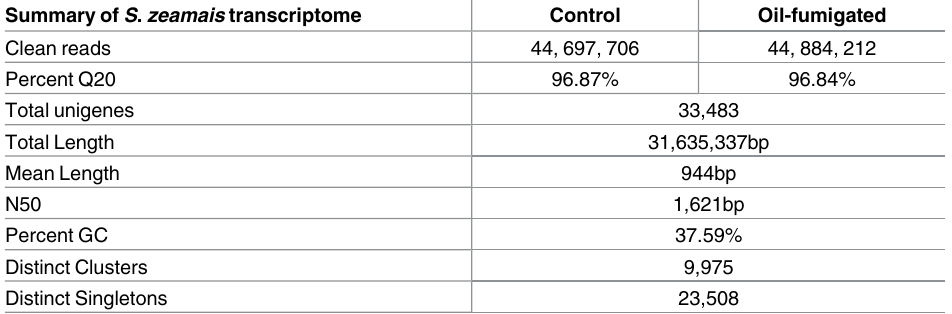
Table 3. Summary statistics of the Illumina sequence reads of S . zeamais transcriptome and the cor- responding assembly. Summary of S . zeamais transcriptome